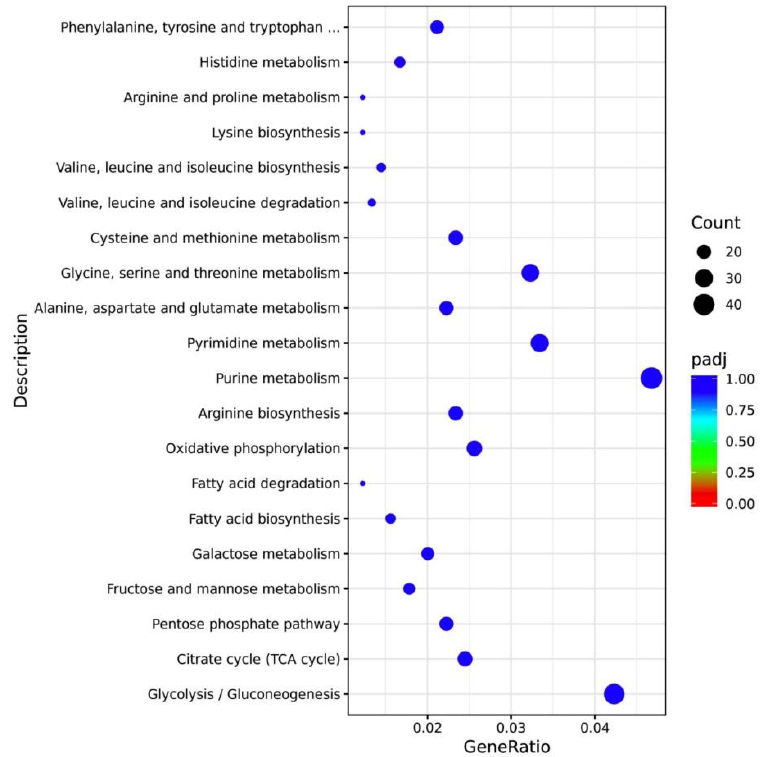
Figure 7. Transcriptome changes in MRSA USA300 after SA2 treatment; twenty COG enrichment differentially expressed genes were profiled.